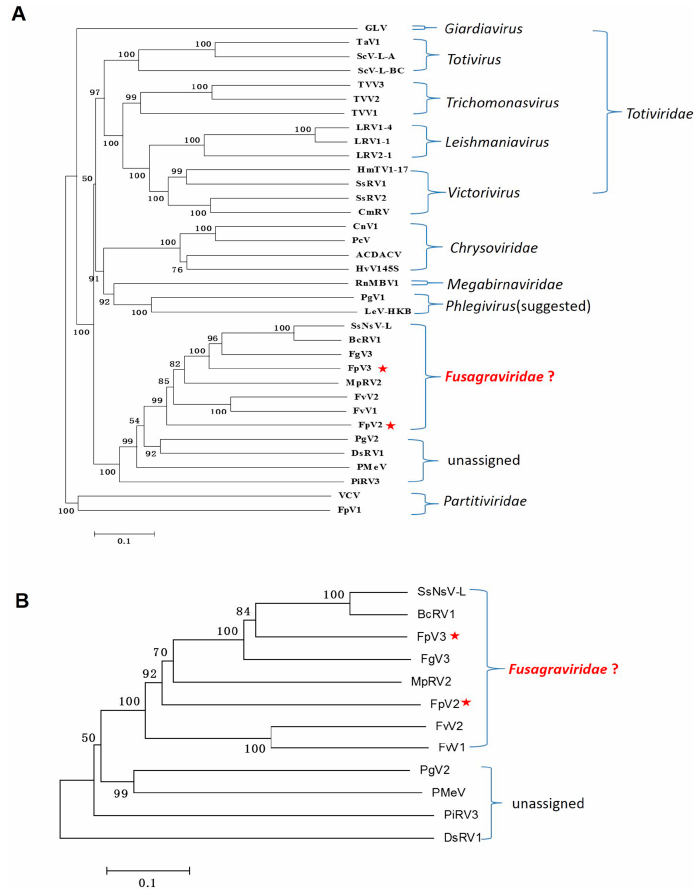
Figure 4. Phylogenetic analysis of FpV2, FpV3 (marked by stars), and related RNA viruses. The phylogenetic tree generated by NJ method (1000 bootstrap replicates) based on the amino acid sequences of the putative RdRp regions ( A ) and the polypeptide P1 ( B ) in MEGA 6.0. In ( A ), two partitivirus sequences (FpV1and VCV) were included as an outgroup, on which the tree is rooted. The scale bar is equivalent to a genetic distance of 0.1 amino acid substitutions per site. “?” means the proposed family name is waiting for approval of ICTV. The abbreviation of virus names and GenBank accession numbers are as follows: ACDACV, Amasya cherry